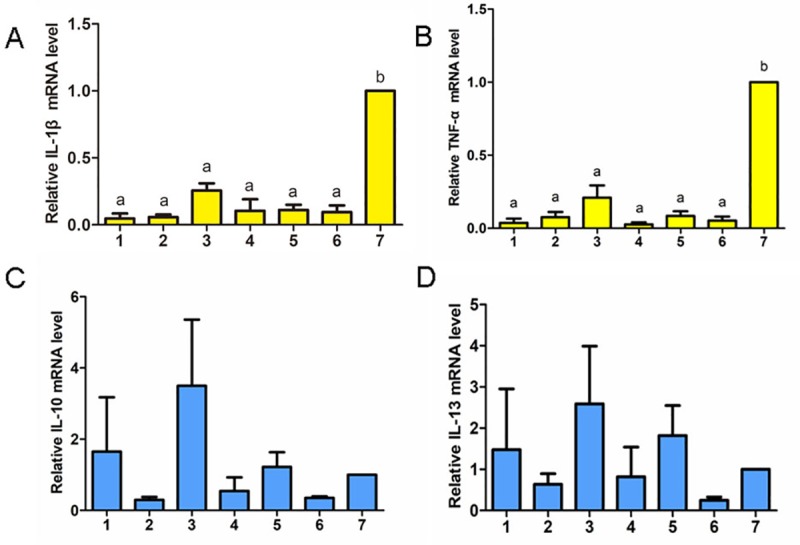
Pro-inflammatory cytokines and anti-inflammatory cytokines mRNA levels of chicks from all groups after the prognosis period.The pro-inflammatory cytokines are shown in yellow color, and the anti-inflammatory cytokines are shown in blue color. The groups with different letters are significantly different (P < 0.05).